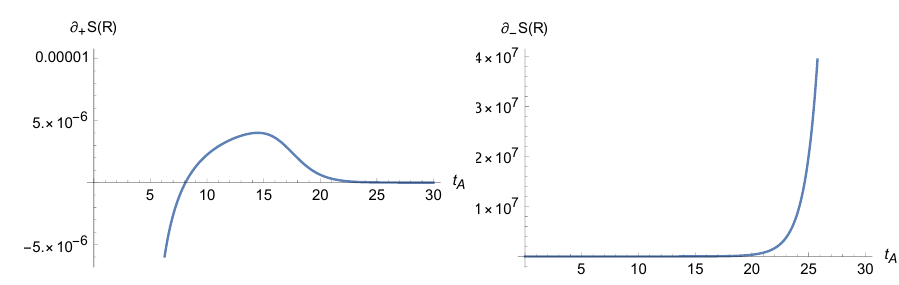
Figure 9 . ∂ ± S ( R ) evaluated on the approximate island. To produce the figures we took ‘ = 1 , Φ s = 50 , Φ 0 = 100 , c = 10 , ˆ r/‘ = 10 3 .